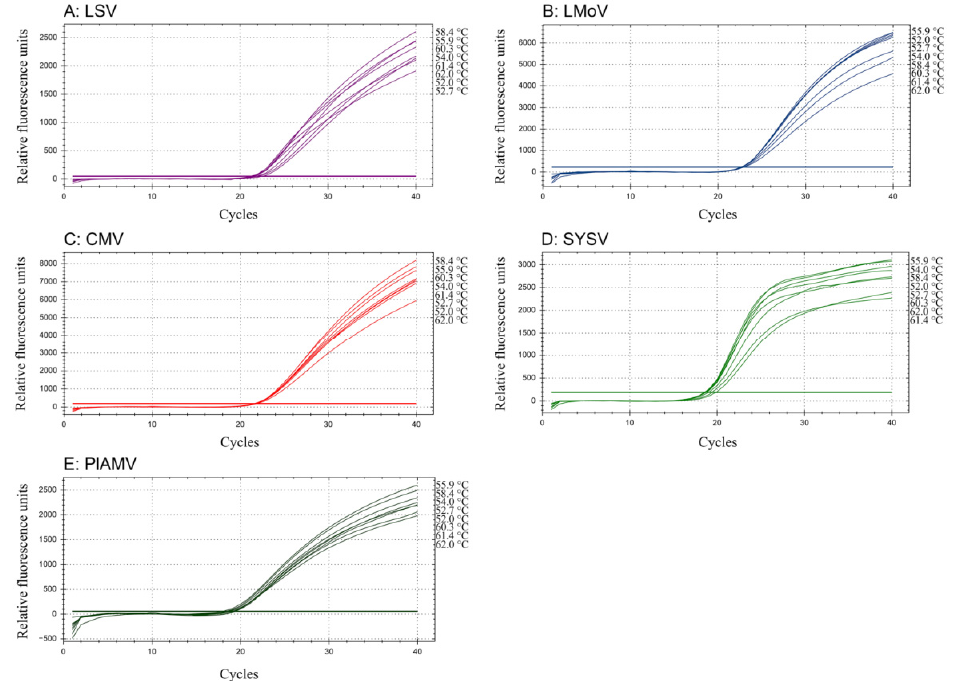
Figure 2. Optimization of the annealing temperature for multiplex TaqMan real-time PCR assay to detect LSV ( A ), LMoV ( B ), CMV ( C ), SYSV ( D ), and PlAMV ( E ).